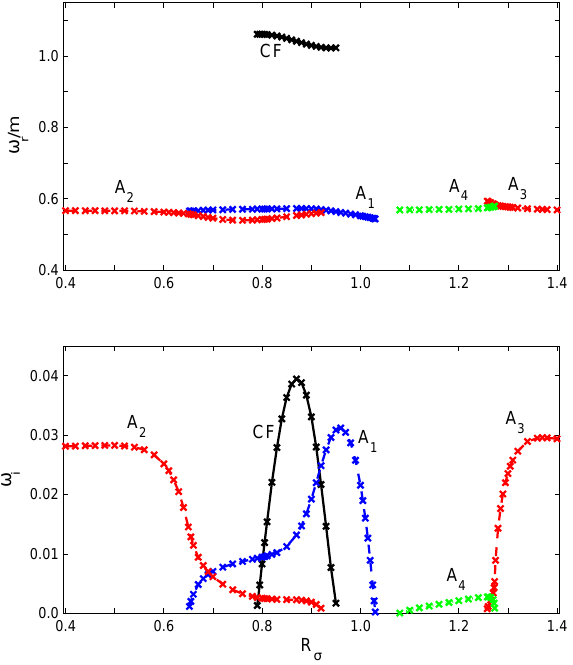
Figure 7. Calculated eigenvalues of the main unstable branches of the m = 2 harmonic, depending on the parameter R – the position σ of the σ 0 ( r ) -jump (relative to R – position of the Ω ( r )-jump), αΩ at fixed value of parameter M * = 15. The model gas disk has the velocity profile (7), (8) with parameters (10), and α = −1.85. Ω min The unperturbed surface density σ 0 ( r ) is described by (13), (14). Top panel – phase angular velocity of waves ω / m , bottom panel – r increment ω . i